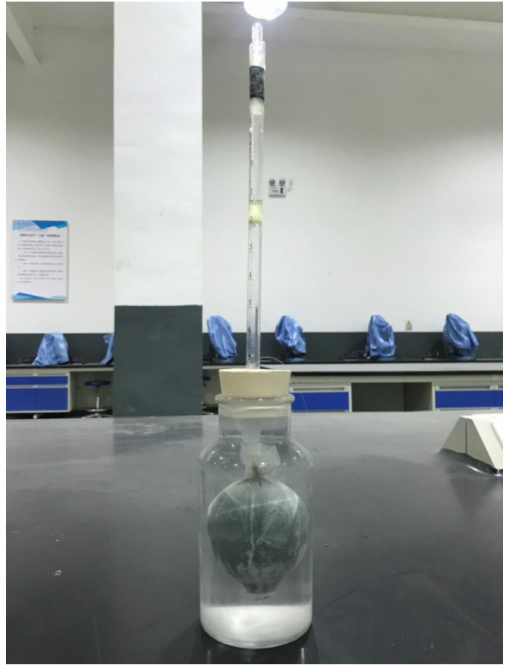
Figure 3. Illustration of testing set-up for the measurements of autogenous shrinkage of alkali-activated